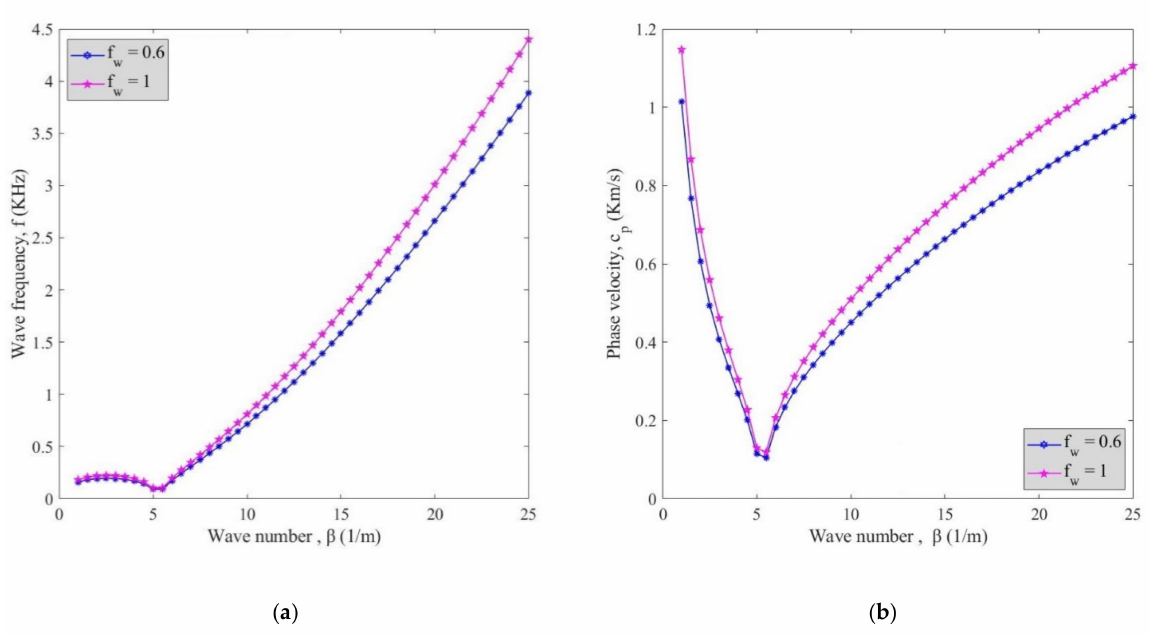
Figure 5. The effect of waviness factor on changes of ( a ) wave frequency and ( b ) phase velocity against wave number.